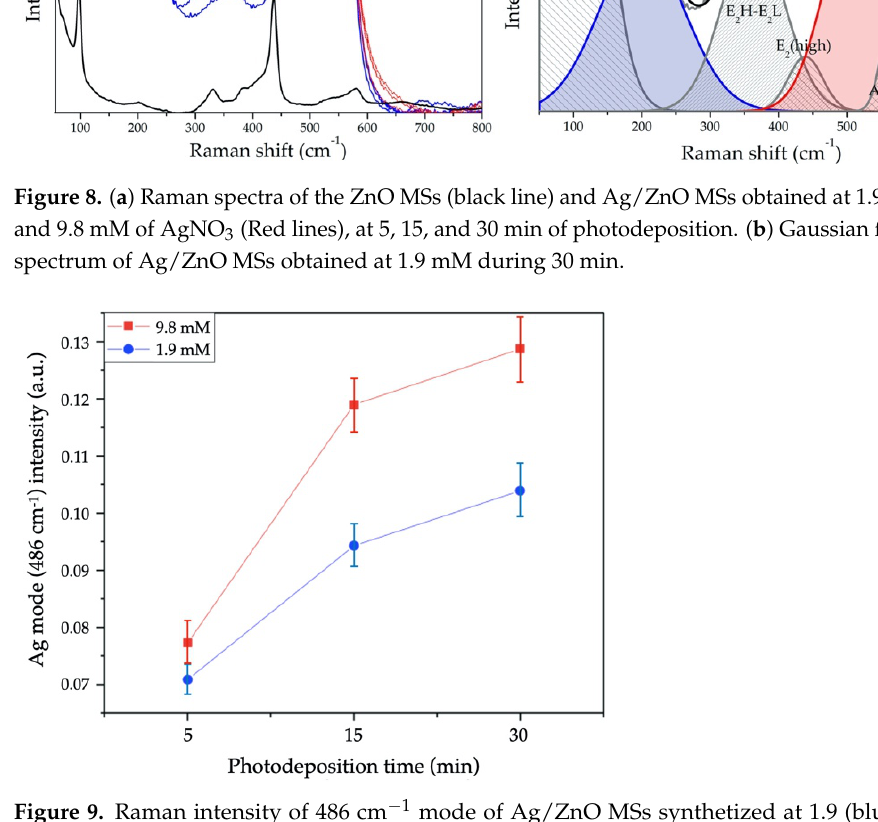
Figure 9. Raman intensity of 486 cm − 1 mode of Ag/ZnO MSs synthetized at 1.9 (blue line) and 9.8 mM of AgNO 3 (red line) during 5, 15, and 30 min of UV irradiation time.